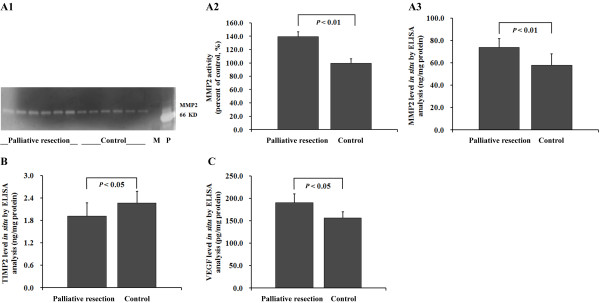
Molecular alterations. (A10 Gelatin zymography assay showed palliative resection activated MMP2. M, size marker; P, positive control. (A2) The percentage of MMP2 activity was elevated 1.4-fold as compared with control (P < 0.01). (A3) Palliative resection up-regulated the tumor MMP2 level (P < 0.01). (B) Palliative resection down-regulated tumor the TIMP2 level (P < 0.05). (C) Palliative resection up-regulated tumor the VEGF level (P < 0.05). The bars indicate the means ± SD.